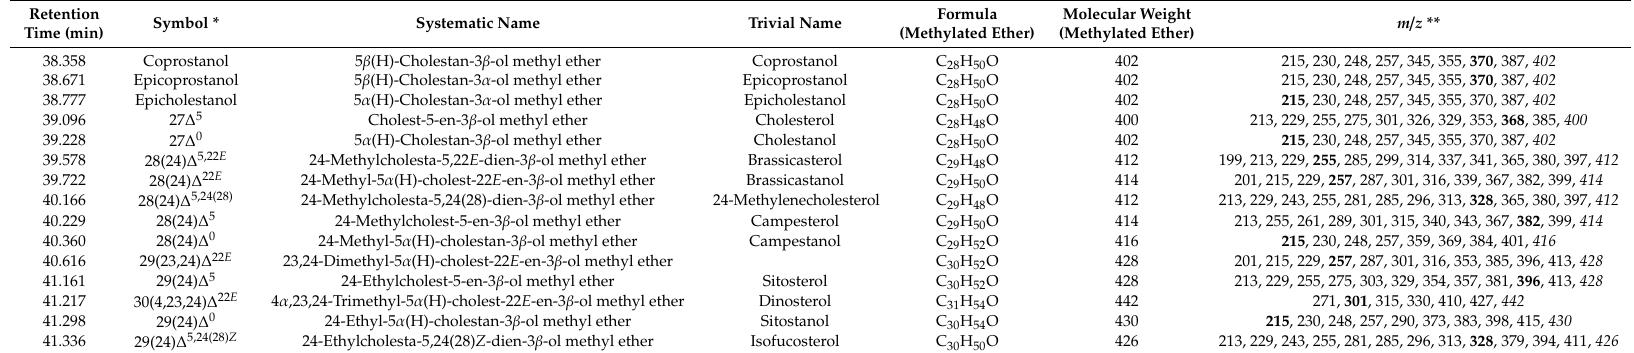
Table 1. Sterols identified from the Yatsu surface